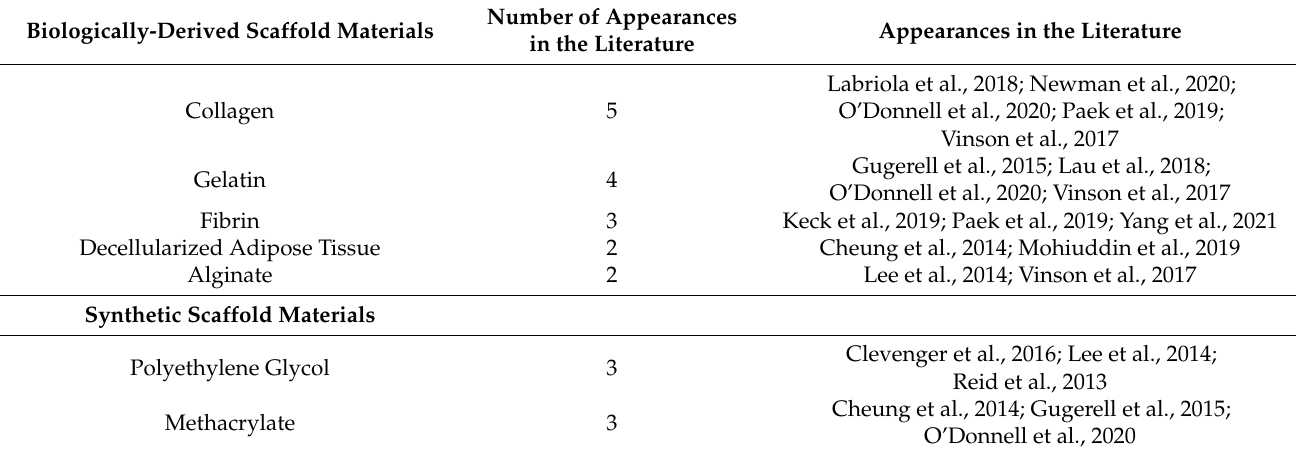
Table 4. Most common synthetic and biologically-derived scaffold materials reported in the literature. Results reflect the number of articles in which a specific material is used as a component in a scaffold. Biologically-Derived Scaffold